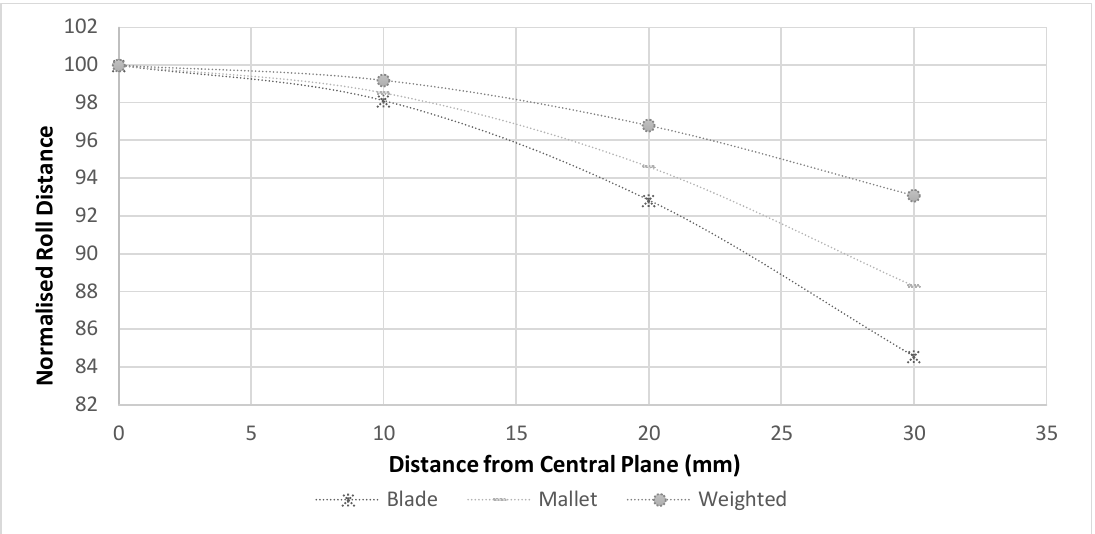
Figure 4. Normalised roll distance for each of the body designs.